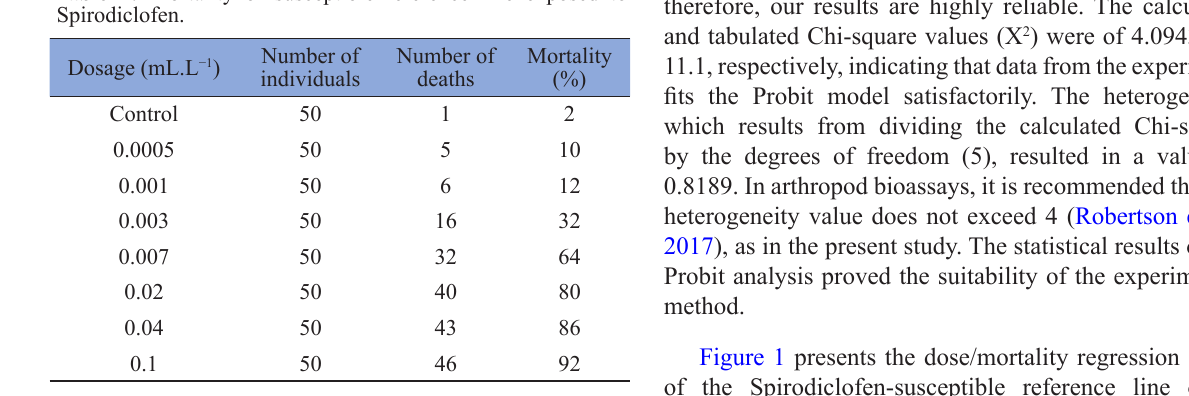
Table 3: Probit analysis to characterize the basic line of susceptibility of T. urticae to Spirodiclofen. LC 50 Population (CI 95%)